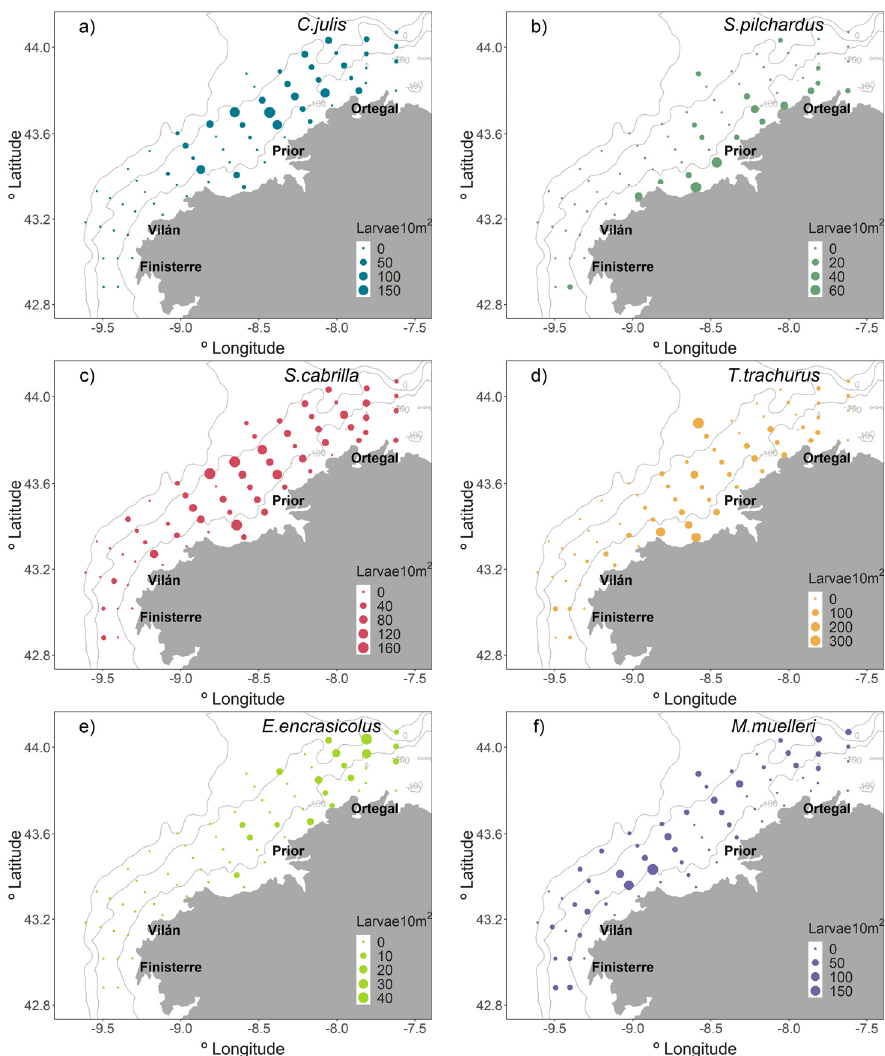
Figure 6. Geographical distribution of the most abundant species. Abundance in larvae per 10 m 2 of ( a ) Coris julis , ( b ) Sardina pilchardus , ( c ) Serranus cabrilla , ( d ) Trachurus trachurus , ( e ) Engraulis encrasicolus , ( f ) Maurolicus muelleri .